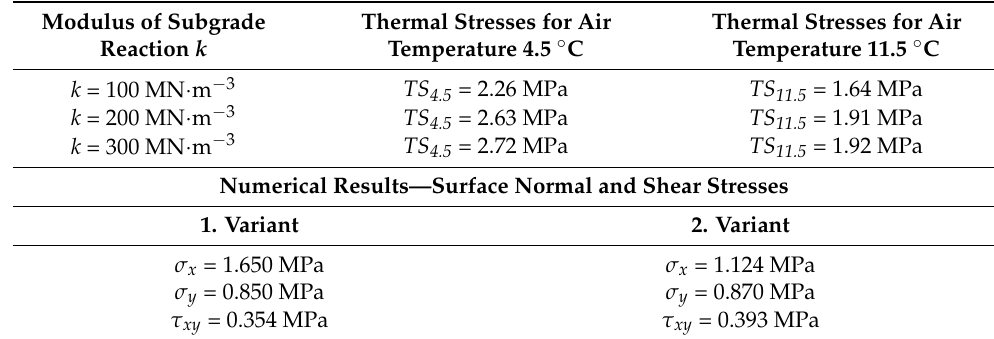
Table 6. The summarized results.